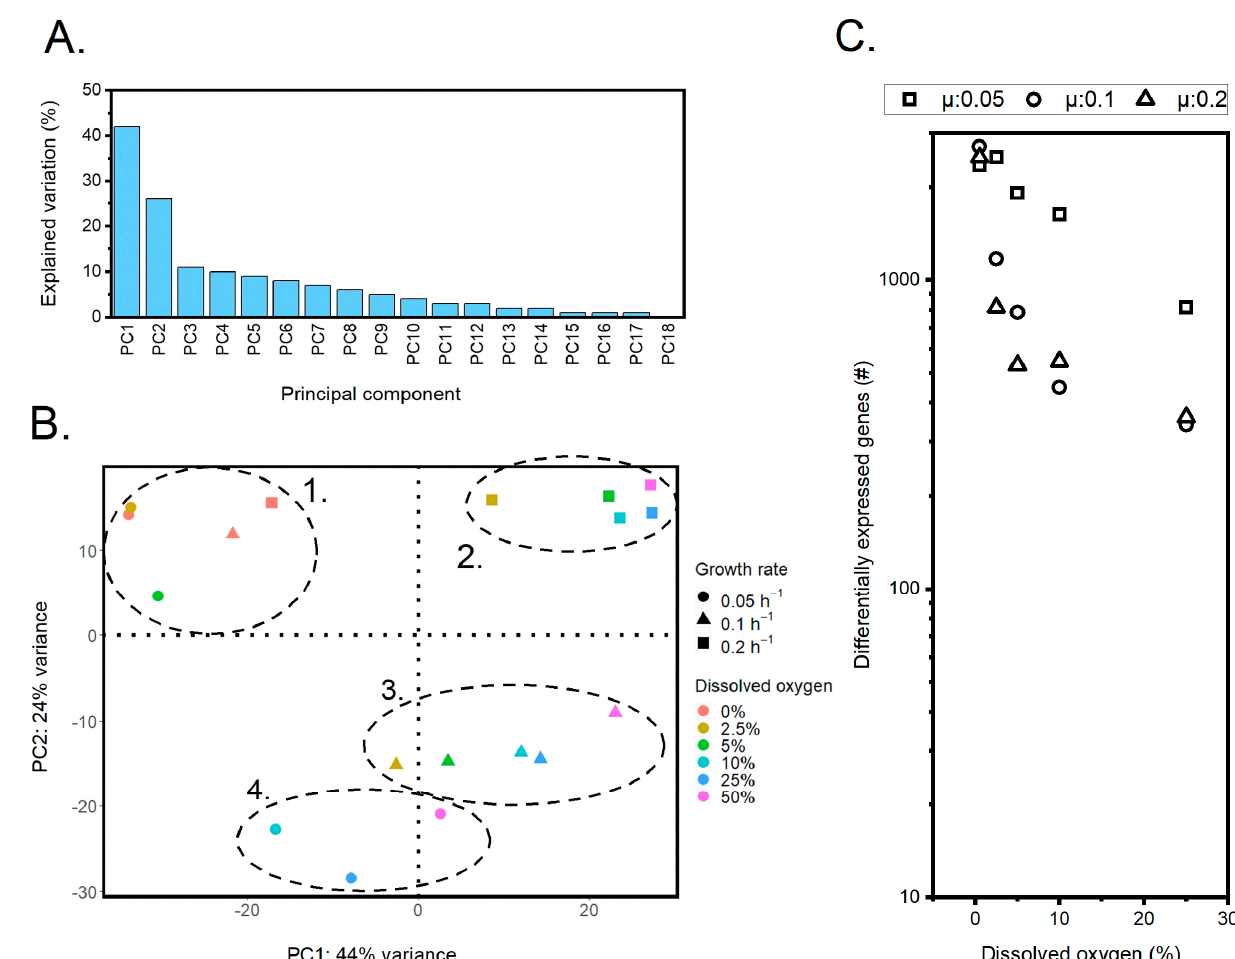
Figure 5. An overview of transcriptome analysis with principal components and differentially ex- pressed genes. ( A ) Explained variance by all principal components that were identified. ( B ) Explained variance by PC1 and PC2 plotted against one another. Four distinct clusters could be identified. The samples from the oxygen-limited conditions were grouped together in cluster one. Cluster two covered the setups with a growth rate of 0.2 h − 1 , while clusters three and four covered the growth rates of 0.1 h − 1 and 0.05 h 1 , respectively. ( C ) Number of differentially expressed genes (log scale) when comparing the reference condition of 50% dissolved oxygen to 0.5, 2.5, 5, 10, and 25% dissolved oxygen for each individual growth rate.